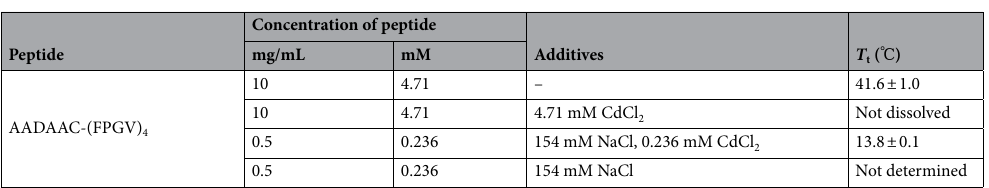
Table 2. T t values of AADAAC-(FPGV) 4 . Mean T t values with SE were shown in the table. The peptide was dissolved in Tris–HCl buffer solution (50.0 mM Tris, pH 8.4). The measurements were repeated at least three